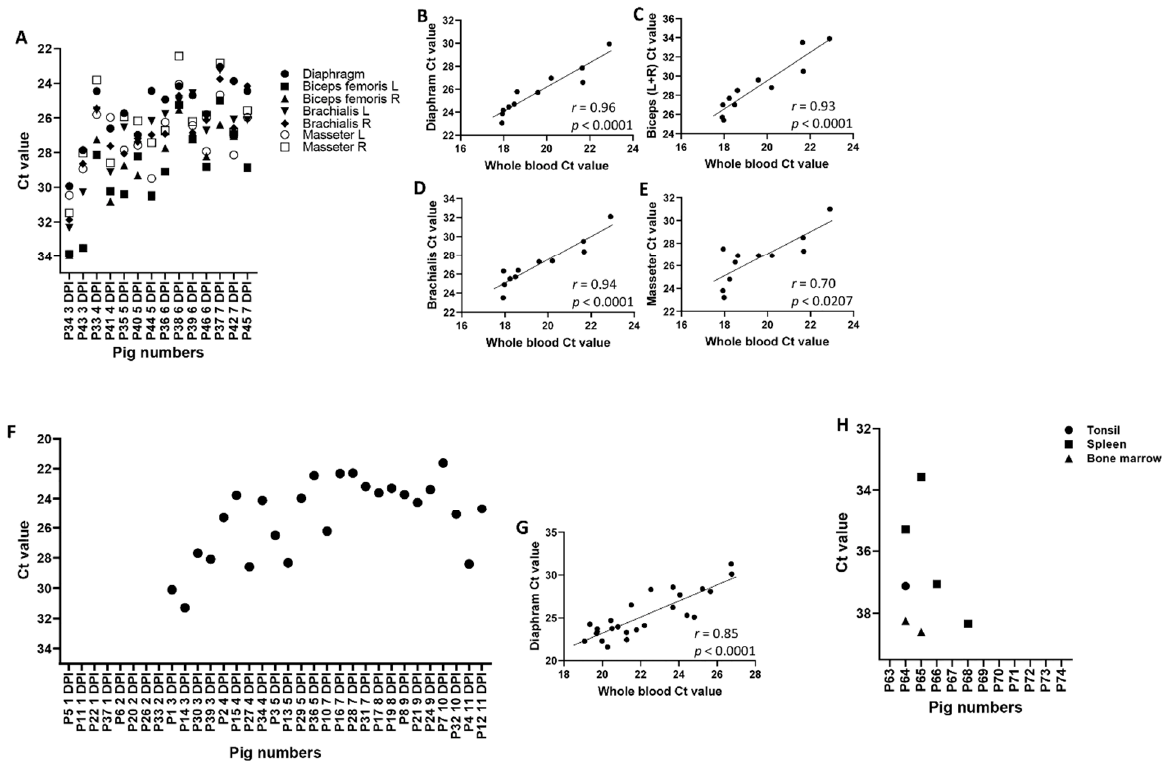
Figure 3. ASFV genomic material in the meat exudate (ASFV Malawi LIL 18/2 and ASFV Estonia 2014) and tissues (ASFV OURT/88/3) from infected pigs. Groups of pigs ( n = 14–39) were infected oronasally with 1 × 10 5 TCID 50 ASFV Malawi LIL 18/2 ( A ) or 2 × 10 5 TCID 50 ASFV Estonia 2014 ( F ), and on indicated dpi, the respective muscles were collected from the pigs, and the extracted meat exudate was assessed for ASFV genomic material by real-time PCR ( A , F ). Spearman’s correlation was also performed between the whole blood and various meat exudate types in the ASFV Malawi LIL 18/2 ( B – E ) and ASFV Estonia 2014 ( G )-infected groups of pigs. In another experiment, tissues from ASFV OURT/88/3-infected pigs ( n = 12) were also assessed for ASFV genomic material by real-time PCR ( H ); for this group, pigs were first infected oronasally with 1 × 10 5 TCID 50 ASFV OURT 88/3 and re-infected with 1 × 10 6 TCID 50 ASFV OURT 88/3 on 14 dpi. Ct value of ≤ 35.99, positive; p < 0.05, significant. Dead pigs were excluded from the analysis. Table 1. Side-by-side Ct values of the whole blood and meat exudate from pigs infected with ASFV Malawi LIL 18/2 or ASFV Estonia 2014.